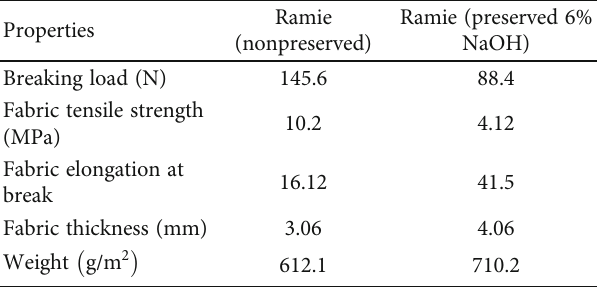
Table 2: Properties of